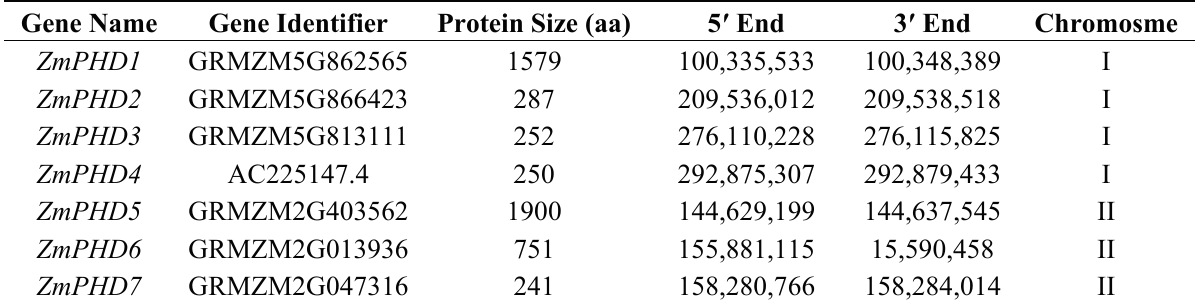
Table 1. The detailed information of maize PHD family